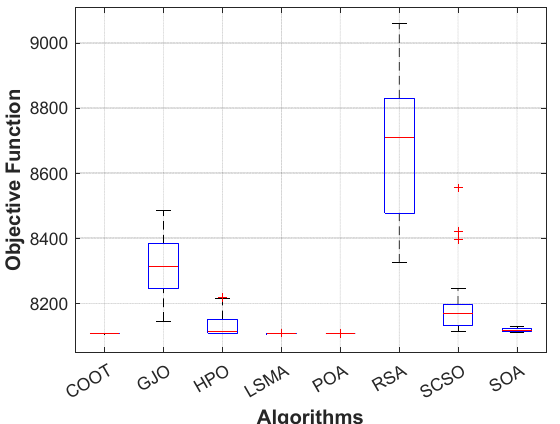
Figure 13. The convergence characteristics of POA and other compared algorithms for case 4 in a standard IEEE 14-bus test system.